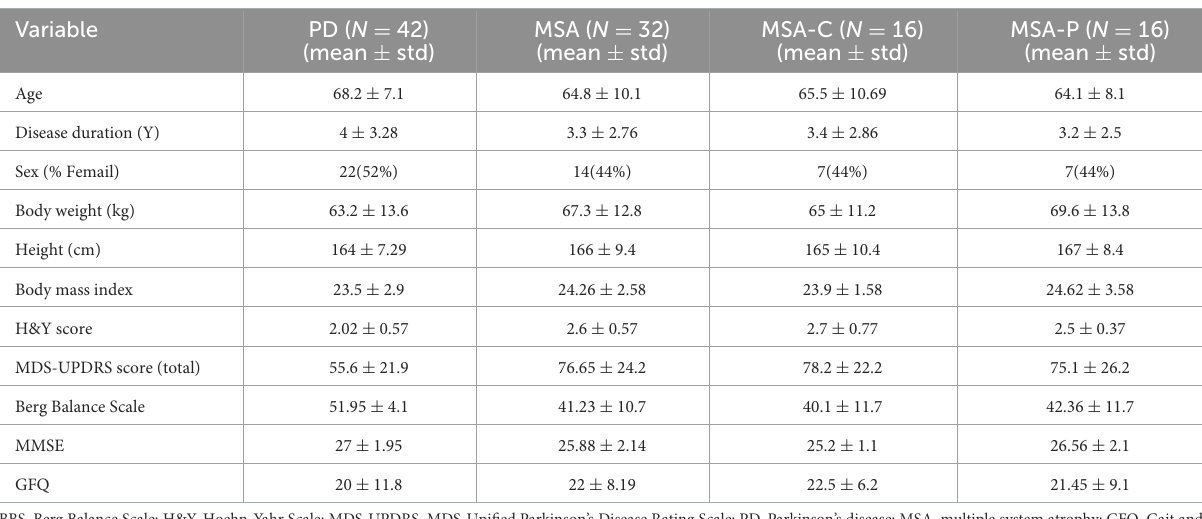
TABLE 1 Demographic data of the PD and MSA groups.